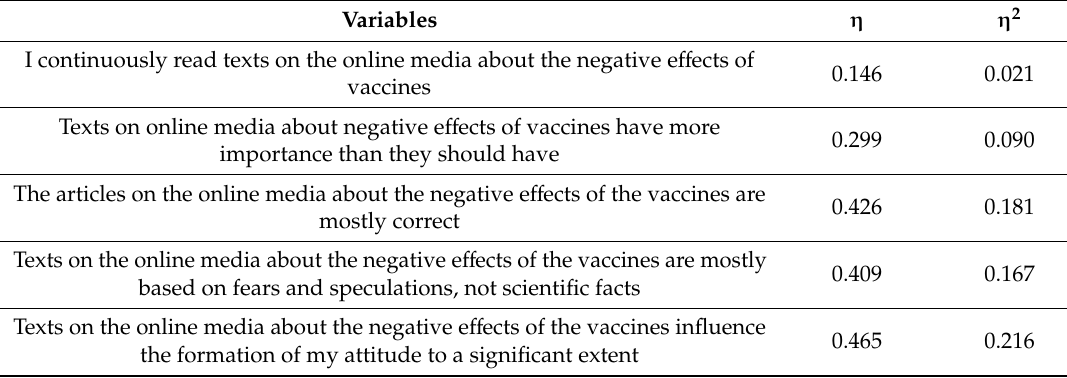
Table 7. Measures of association of online media with attitudes toward